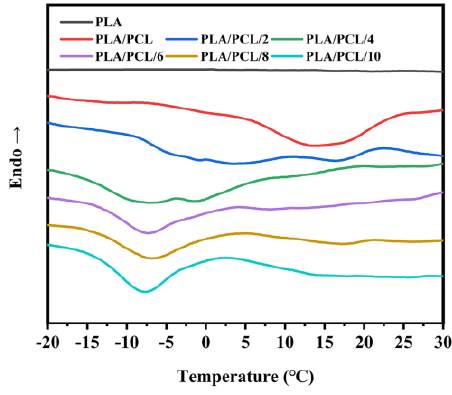
Figure 6. DSC cooling curves of the neat PLA, PLA/PCL and PLA/PCL/EMA-GMA blends in the range of − 20–30 °C.